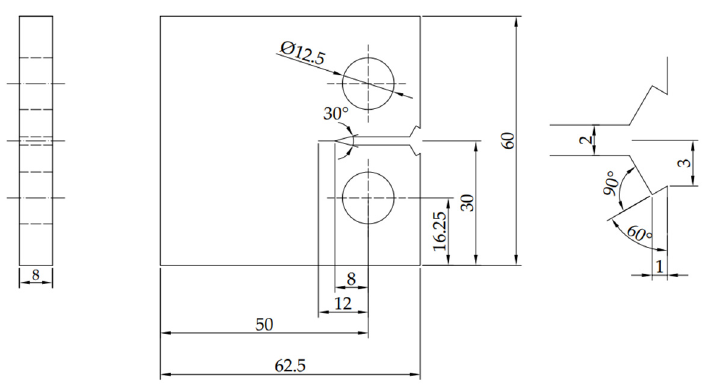
Figure 1. Configuration of CT specimen.